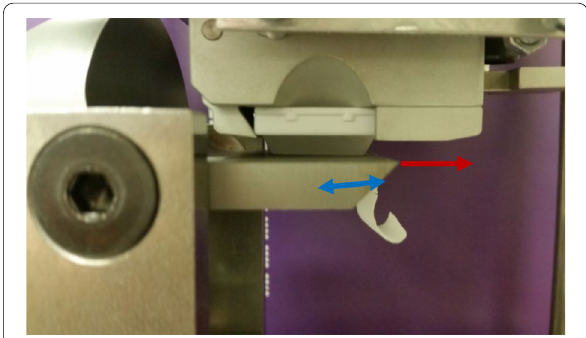
Figure 3 A continuous paraffin wax section was obtained using the designed rig with an inclined ultrasonically assisted cutting (the blue arrow represents vibration directions and the red arrow represents the sectioning